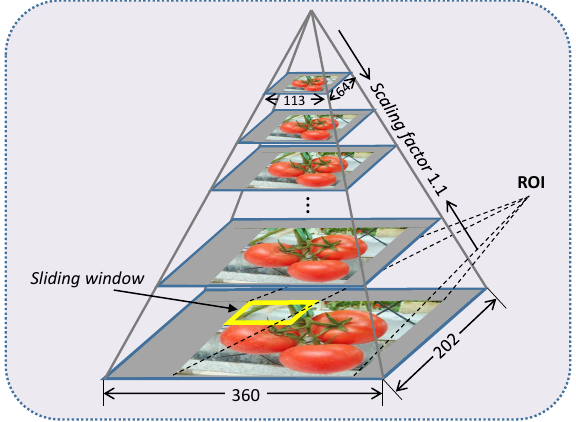
Figure 8. A sketch map of the sliding window and image